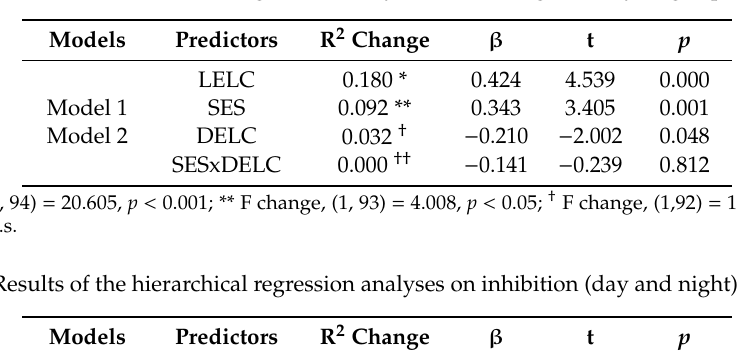
Table 8. Results of the hierarchical regression analyses on working memory (digit span). R 2 = 0.30.